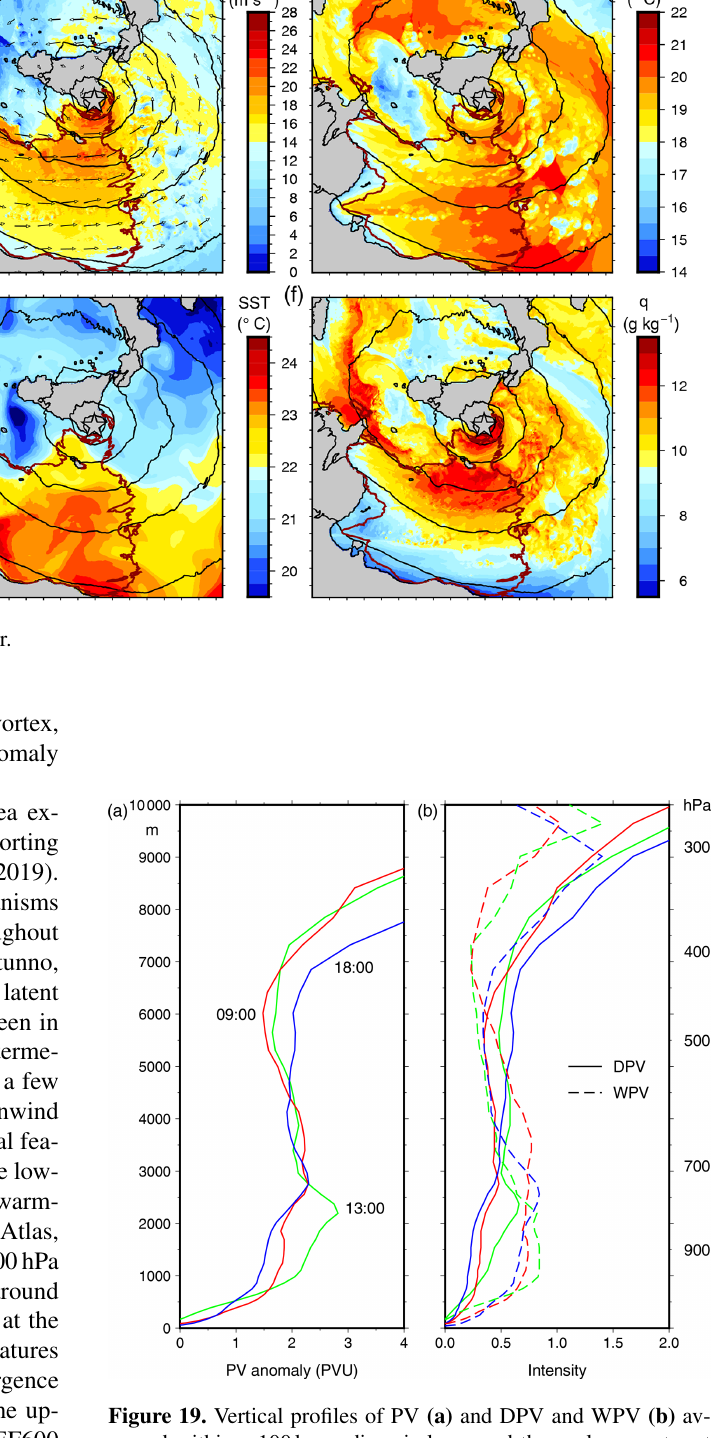
Figure 19. Vertical profiles of PV (a) and DPV and WPV (b) av- eraged within a 100km radius circle around the cyclone centre at 09:00 (red), 13:00 (green) and 18:00UTC (blue) on 7 November in the CPL